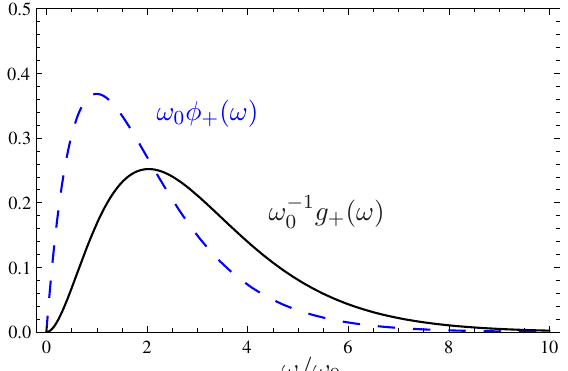
Figure 2 . The two-particle twist-4 DA g + ( ω ) in Model I (5.14). For this plot we have taken R = λ 2 /λ 2 = 1 / 2 (5.4). The leading-twist DA φ + ( ω ) (5.9) is shown by dashes for E H